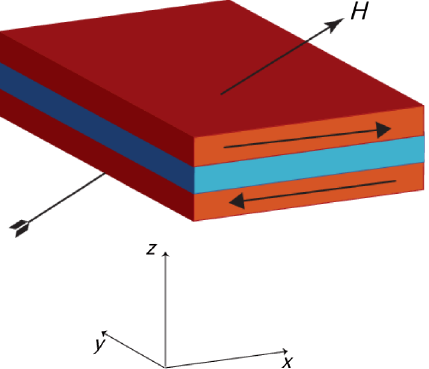
.FIG. 1. The considered geometry of the atomistic simulations. The red and blue slabs represent Fe and Cr, respectively. The arrows in the slabs represent directions of